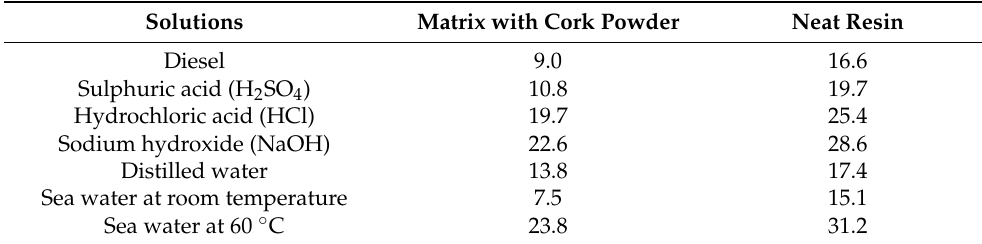
Table 9. Decrease of the impact bending stiffness after 30 days of immersion into different harsh solutions compared to the value obtained for non-immersed specimens (values in